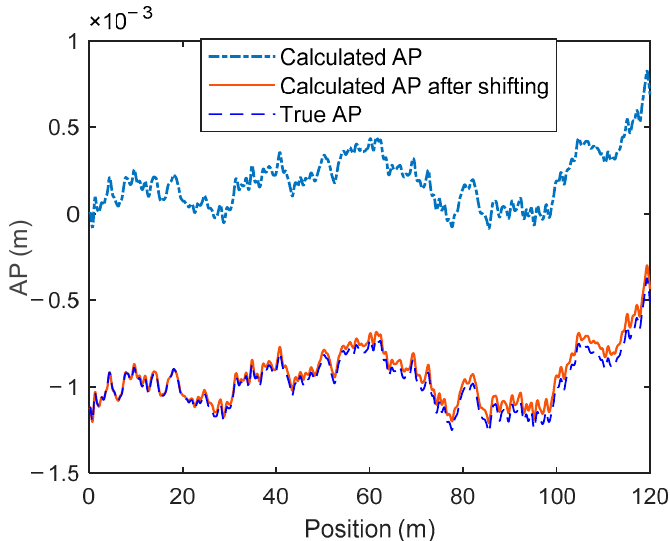
Figure 9. Calculated AP, calculated AP after shifting, and true AP (off-bridge) for Profile 1, State 7, and Run No. 1.